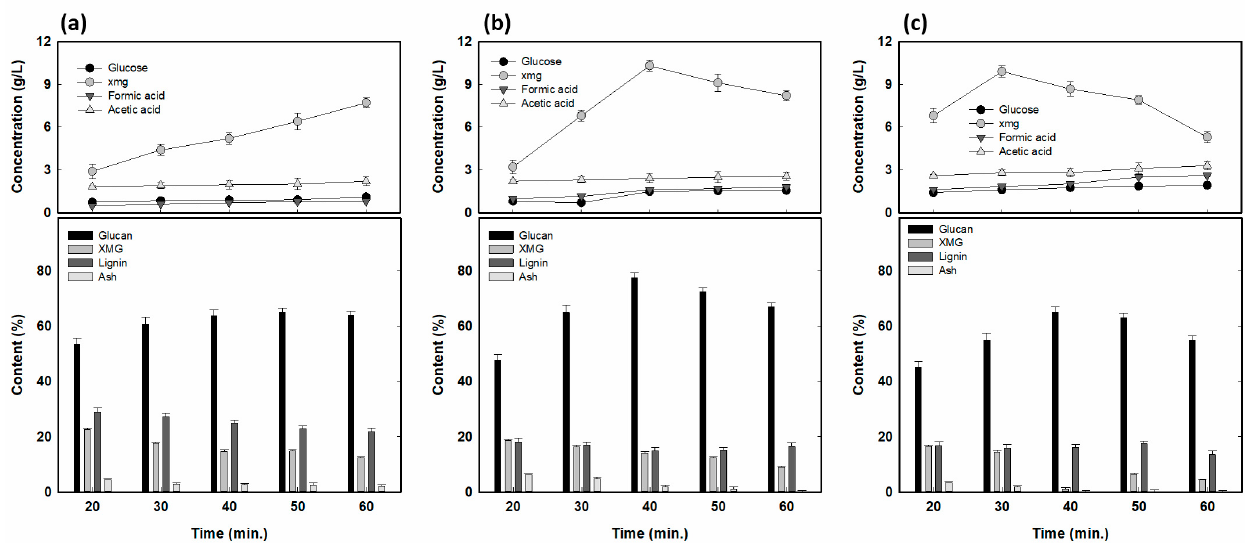
Figure 3. Percentage changes in compositional contents of residual solids (below) and concentration profiles of products in liquid hydrolysates (above) after alkaline fractionation of RH with 6 wt.% NaOH: ( a ) 130 °C, ( b ) 150 °C, ( c ) 170 °C.